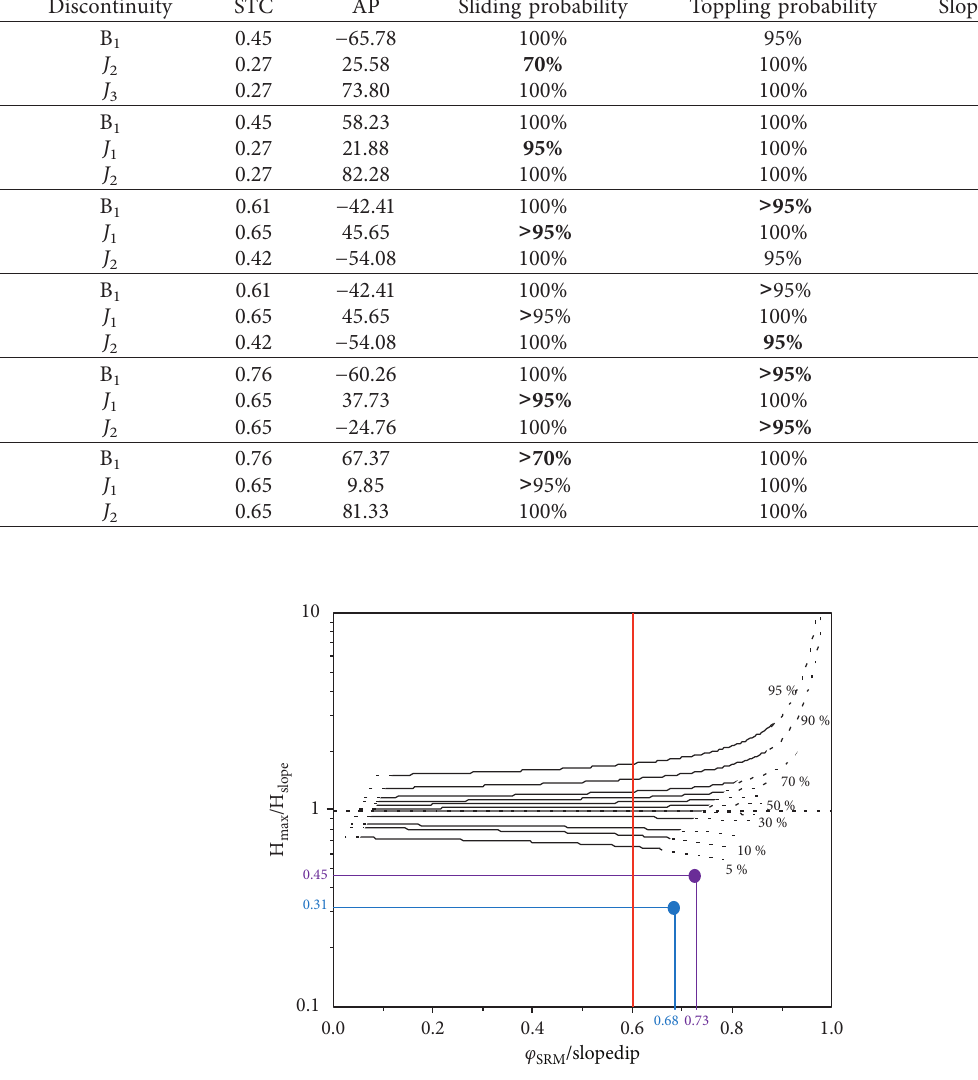
Figure 8: Flowchart of the SSPC methods determined by orientation-independent failure (slope